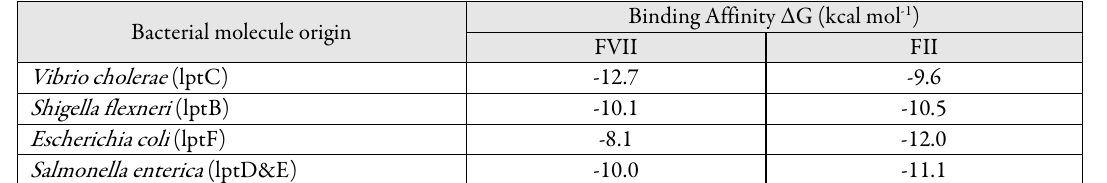
Table 5. Binding affinities of the ClusPro docking output (FVII: coagulation factor VII; FII: coagulation factor